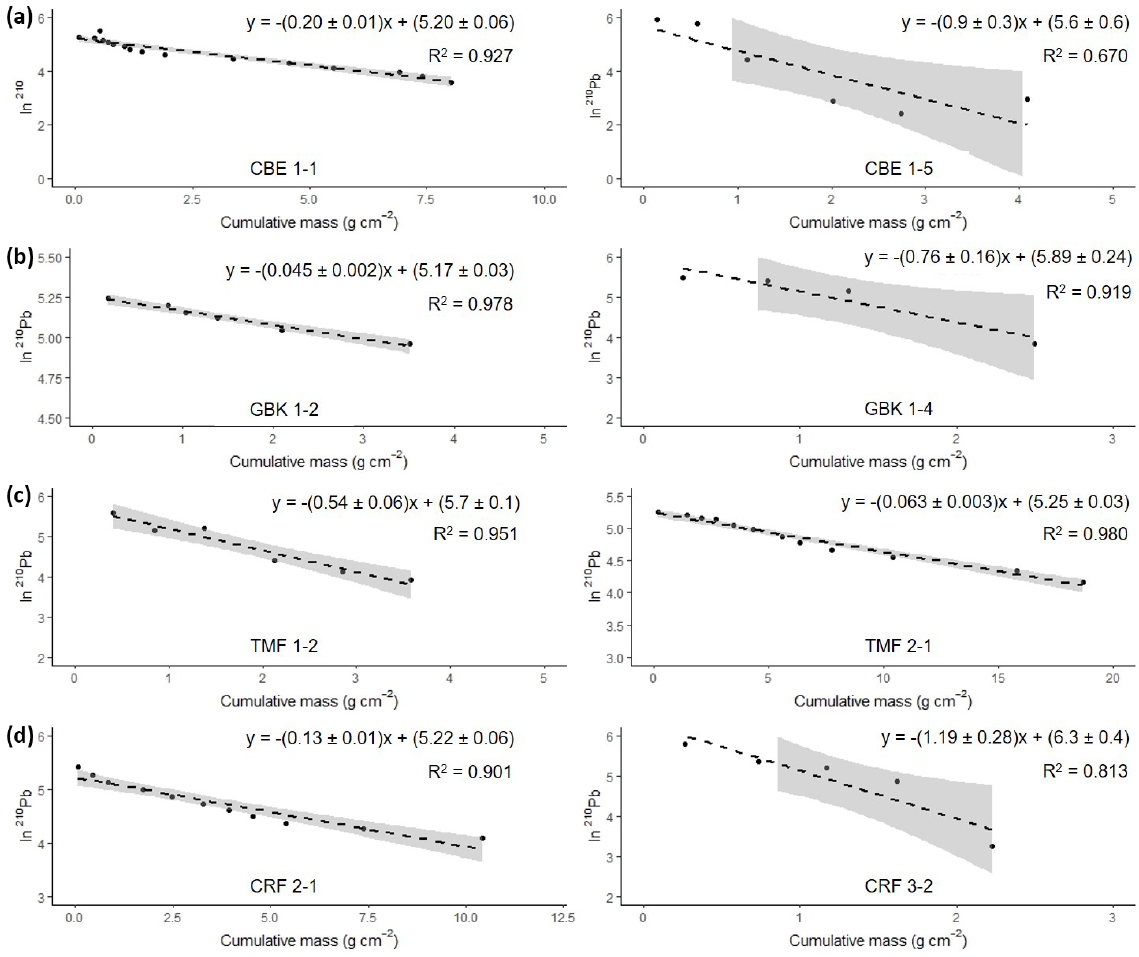
Figure 6. Natural log of excess 210 Pb activity versus cumulative mass from the surface. The equation in each graph shows the results from the regression analyses used for the calculation of the mean accumulation rate (gcm − 2 yr − 1 ) using the CF:CS model. Grey-shaded area represents 95% confidence